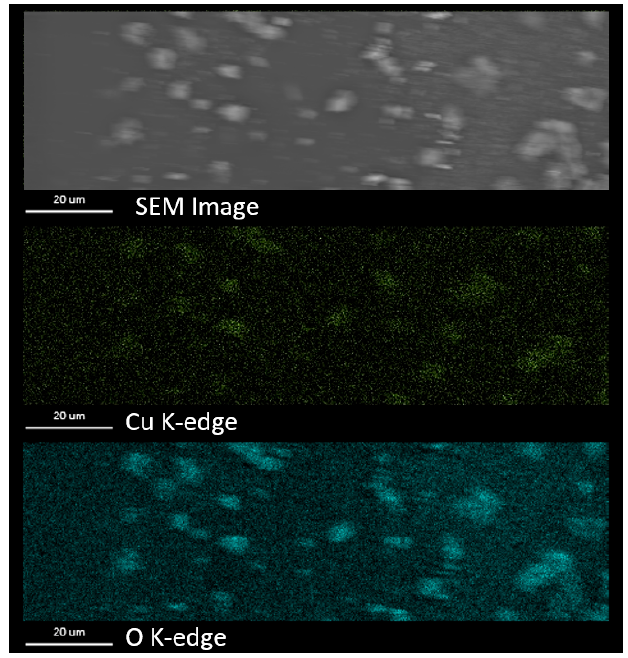
Figure 4. EDX mapping of the SPES@HKUST-1 membrane (5 wt. % of HKUST-1).